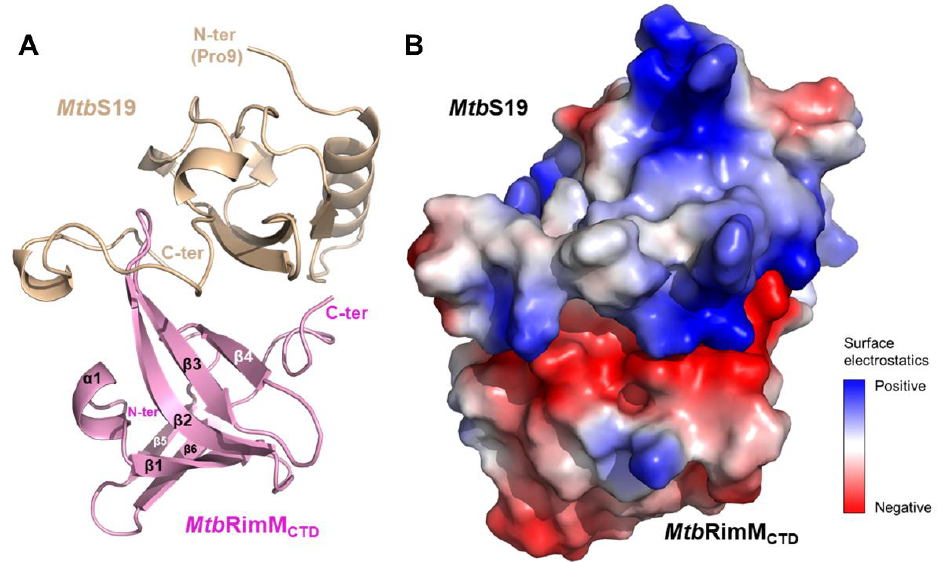
Figure 8. Molecular docking model of the Mtb RimM CTD –S19 complex. ( A ) Cartoon depiction of the docking model. The structure of Mtb S19 (residues 9–93, light brown) was modeled using the crystal structure of Tth RimM-complexed Tth S19 (PDB: 3A1P) as the template. ( B ) Surface electrostatic potentials of the docking model. The binding interface is mainly composed of charged residues. Positively charged residues are primarily from the long loop located near the C-terminus of Mtb S19, and negatively charged residues mostly from Mtb RimM CTD .